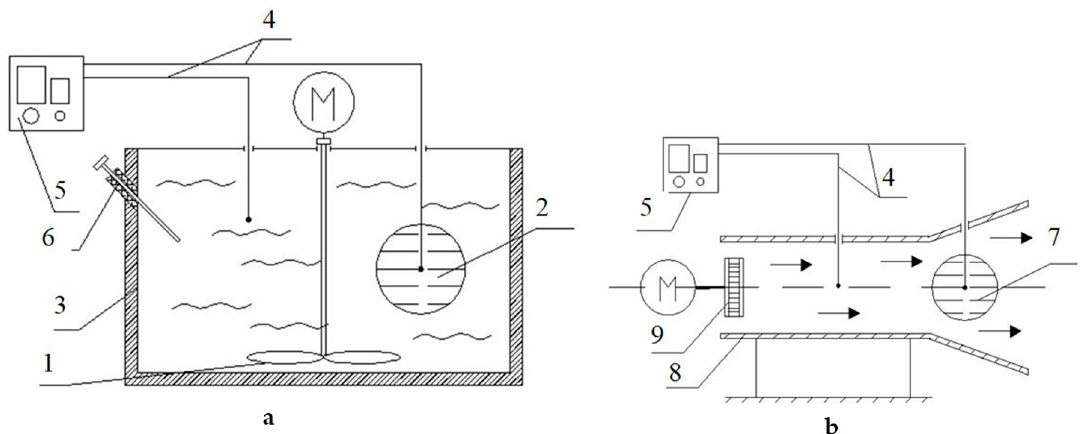
Figure 1. Setup for determining the thermal diffusivity and thermal conductivity coefficient of minced fish; ( a )—water thermostat and ( b )—air thermostat. 1—stirrer; 2— α -calorimeter; 3—liquid